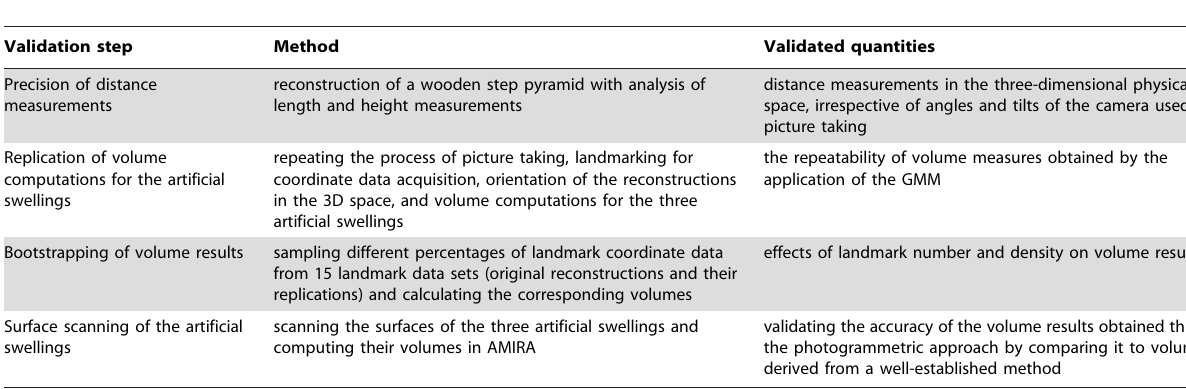
Table 1. Overview to the validation procedure of the